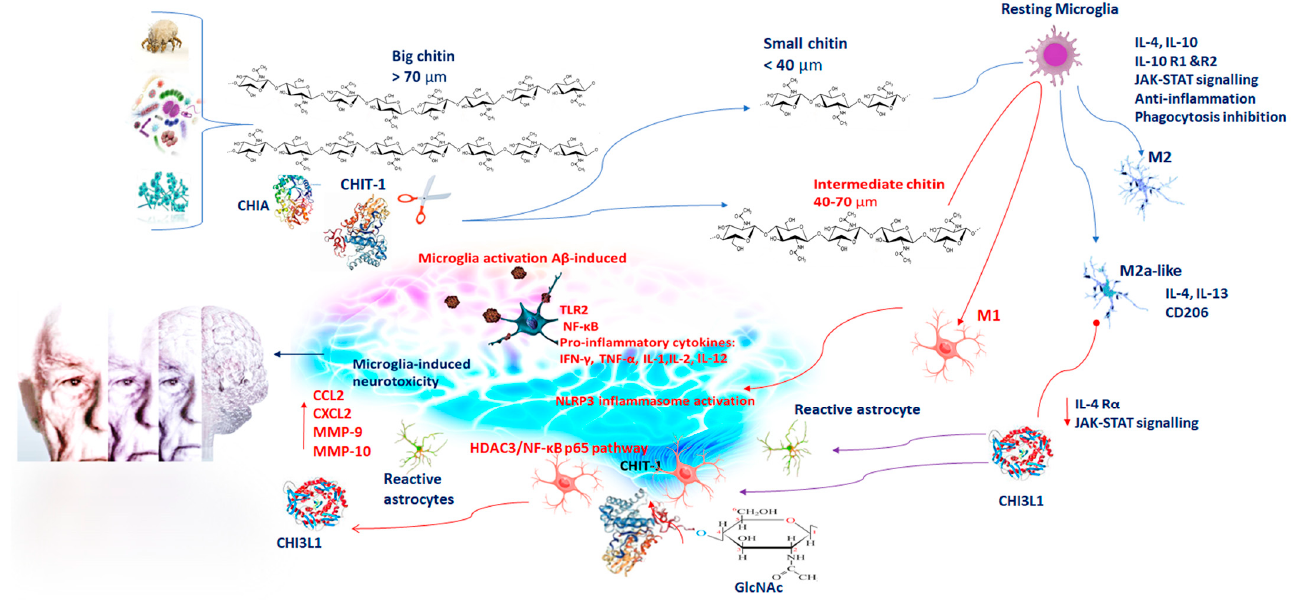
Figure 1. Chitin has both pro-inflammatory and anti-inflammatory effects on the basis of its molecular size: BC (>70 µ m) is inert to the inflammatory response; SC (<40 µ m) exerts an anti-inflammatory response via IL-10 production. IL-10, binding with its own receptors IL-10R1 and IL-10R2, triggers the JAK/STAT signaling pathway, resulting in pro-inflammatory cytokine and phagocytosis inhibition; IC (40–70 µ m) induces pro-inflammatory responses via TLR2- and NF- κ B-dependent pathways for IFN- γ , TNF- α , IL1, IL2, and IL12 production. Microglial cells engulfing chitin debris, GlcNAc polymers, and A β induce NLRP3 inflammasome activation and neurotoxicity. CHIT-1 and CHIA are the most important active enzymes able to degrade chitin polymers. CHIT-1 modulates neuroinflammation via the HDAC3/NF- κ B p65 pathway contributing to AD progression. Microglia polarize in M1 and M2, displaying pro-inflammatory and anti-inflammatory phenotypes, respectively. The M1-polarized phenotype promotes neuronal damage, whereas the M2-polarized phenotype is immunosuppressive and neuroprotective. M2a-like microglia induce CHI3L1, IL13, and CD206. CHI3L1 modulates IL-4R α expression and STAT6 phosphorylation, affecting M2 polarization. CHI3L1 is expressed in microglia, infiltrating macrophages and astrocytes. The expression of CHI3L1 is induced by pro-inflammatory cytokines, including IL-6, IFN- γ , IL-1 β , and TNF- α . Its regulation by IL-6 and TNF- α needs NF- κ B activation. CHI3L1 is induced by inflammatory proteins, such as MMP-10, CX3CL1, and 4E-BP1, and therefore, its activity facilitates AD neuroinflammation. Blue arrows represent induction; red arrows represent inhibition. Abbreviation= BC, IC, SC: big, intermediate, small, chitin; IL: interleukin; TLR2: Toll–like receptor 2; NF- κ B: nuclear factor kappa-light-chain-enhancer of activated B cells; IFN- γ : interferon-gamma; TNF- α : tumor necrosis factor- α ; GlcNAc: β -1,4-linked N -acetylglucosamine; A β : beta-amyloid protein; NLRP3: NLR Family Pyrin Domain Containing 3; CHIT-1: